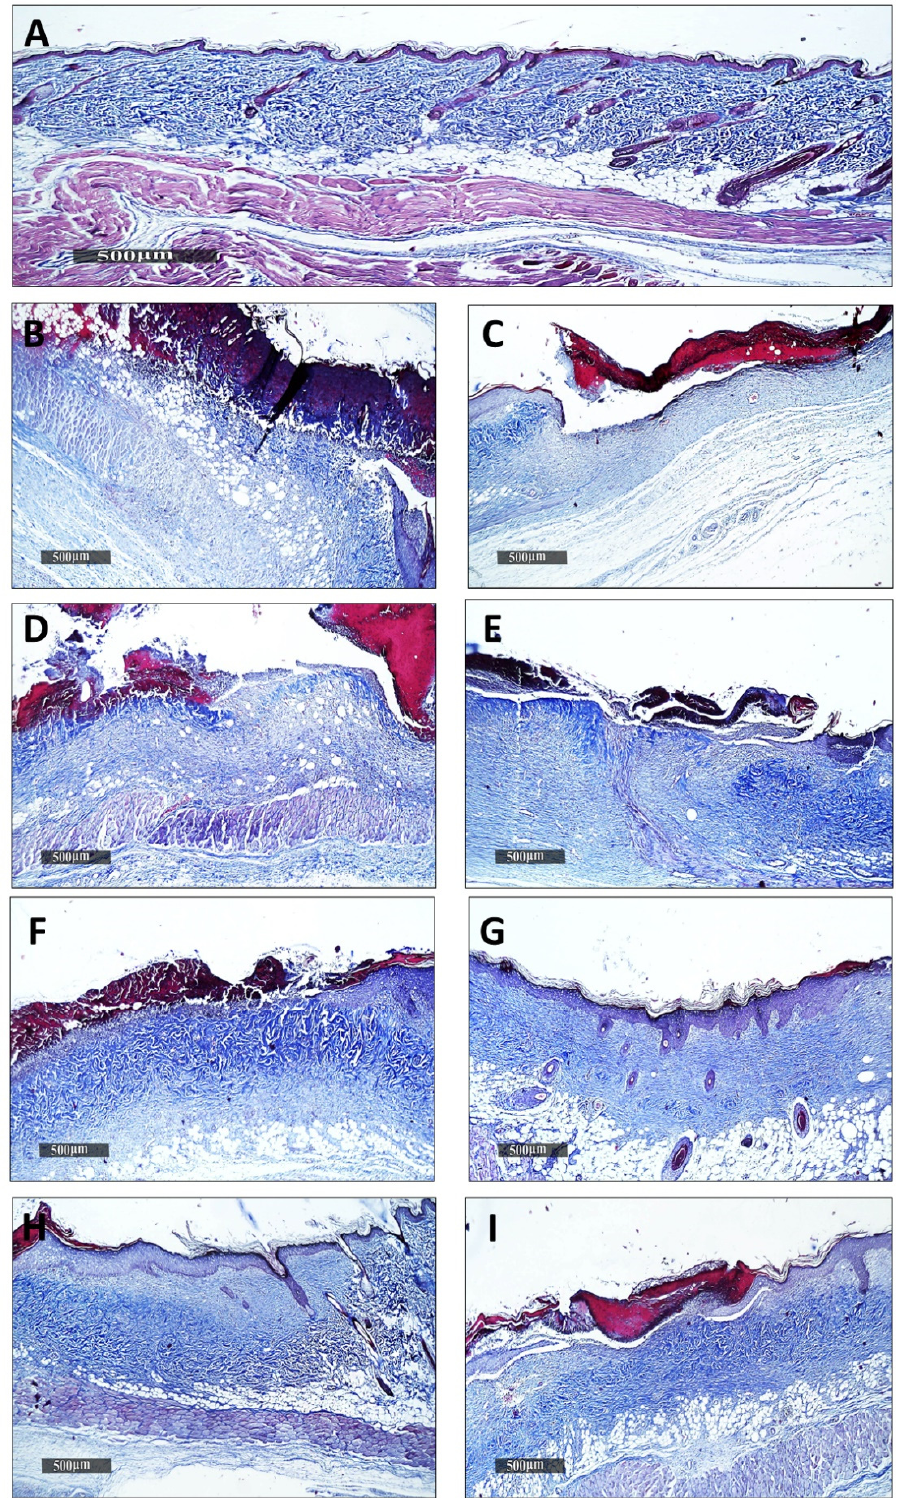
Figure 4. Dermal collagen fibers of different experimental groups; ( A ), dermal collagen fibers of normal health tissue group I; ( B ), group II, ( C ), group III, ( D ): group IV, ( E ), group V, ( F ), group VI; ( G ), group VII; ( H ), group VIII; ( I ), group IX, Group codes are shown in Table 4. (Masson’s Trichome